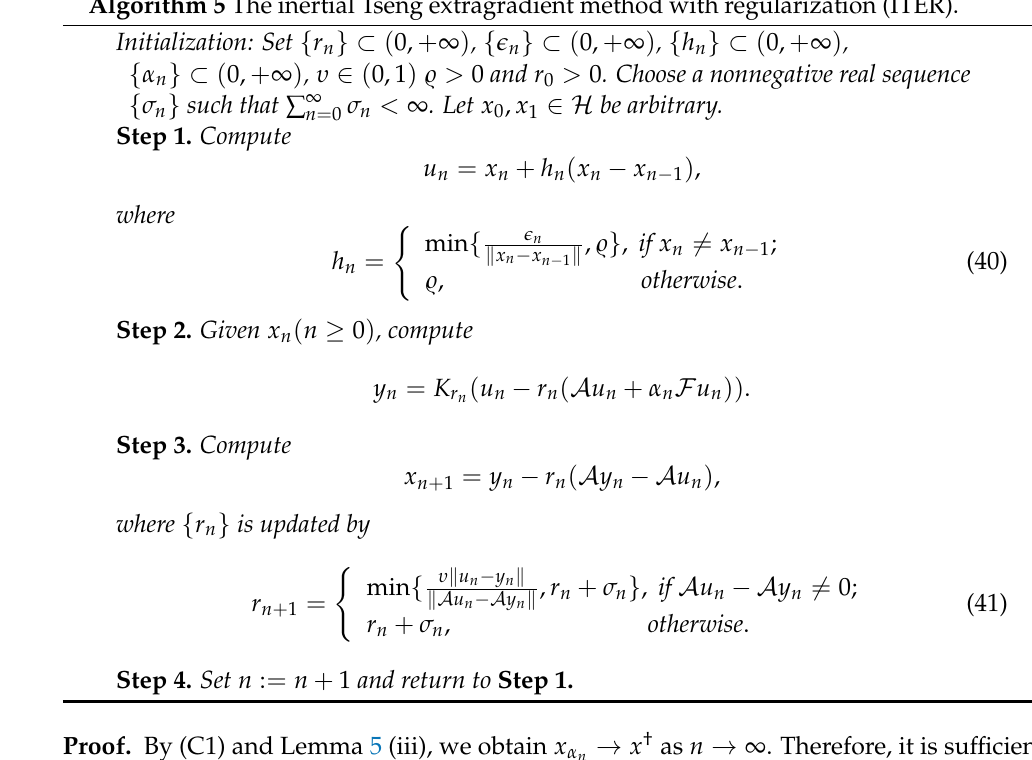
Algorithm 5 The inertial Tseng extragradient method with regularization